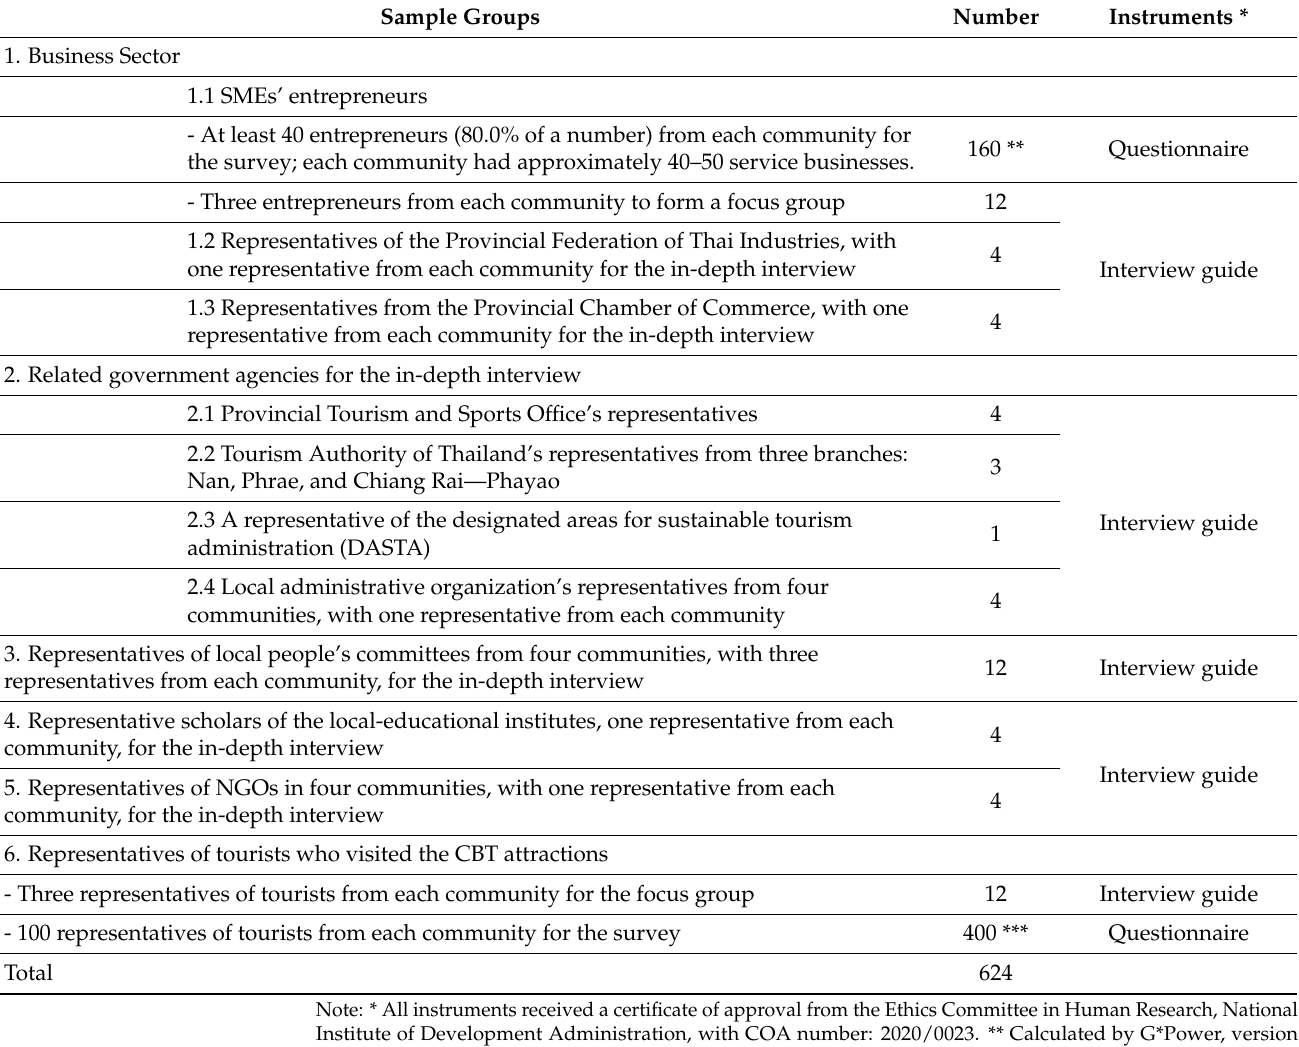
Table 2. Sample groups and instruments for data